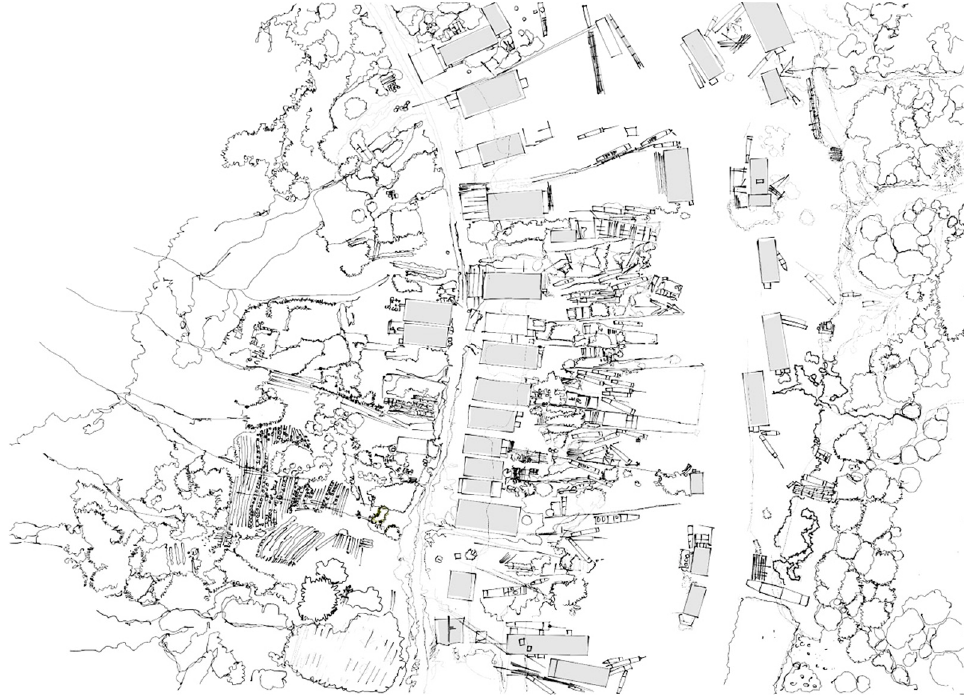
Figure 8. Village tissue in Peam Bang (dry season). The rich landscape/settlement mosaic reveals the living conditions at the land − water margin. Incredible systems of pathways, bamboo bridges, link various landscape and settlement structures. The domesticated micro − habitats are associated with the subtle change degrees of wetness. From the water to the edge of the forest, there are fish traps, hanging vegetable gardens, corn fields, grass fields, shrubs, and higher trees (Linh Vu, April 2022).